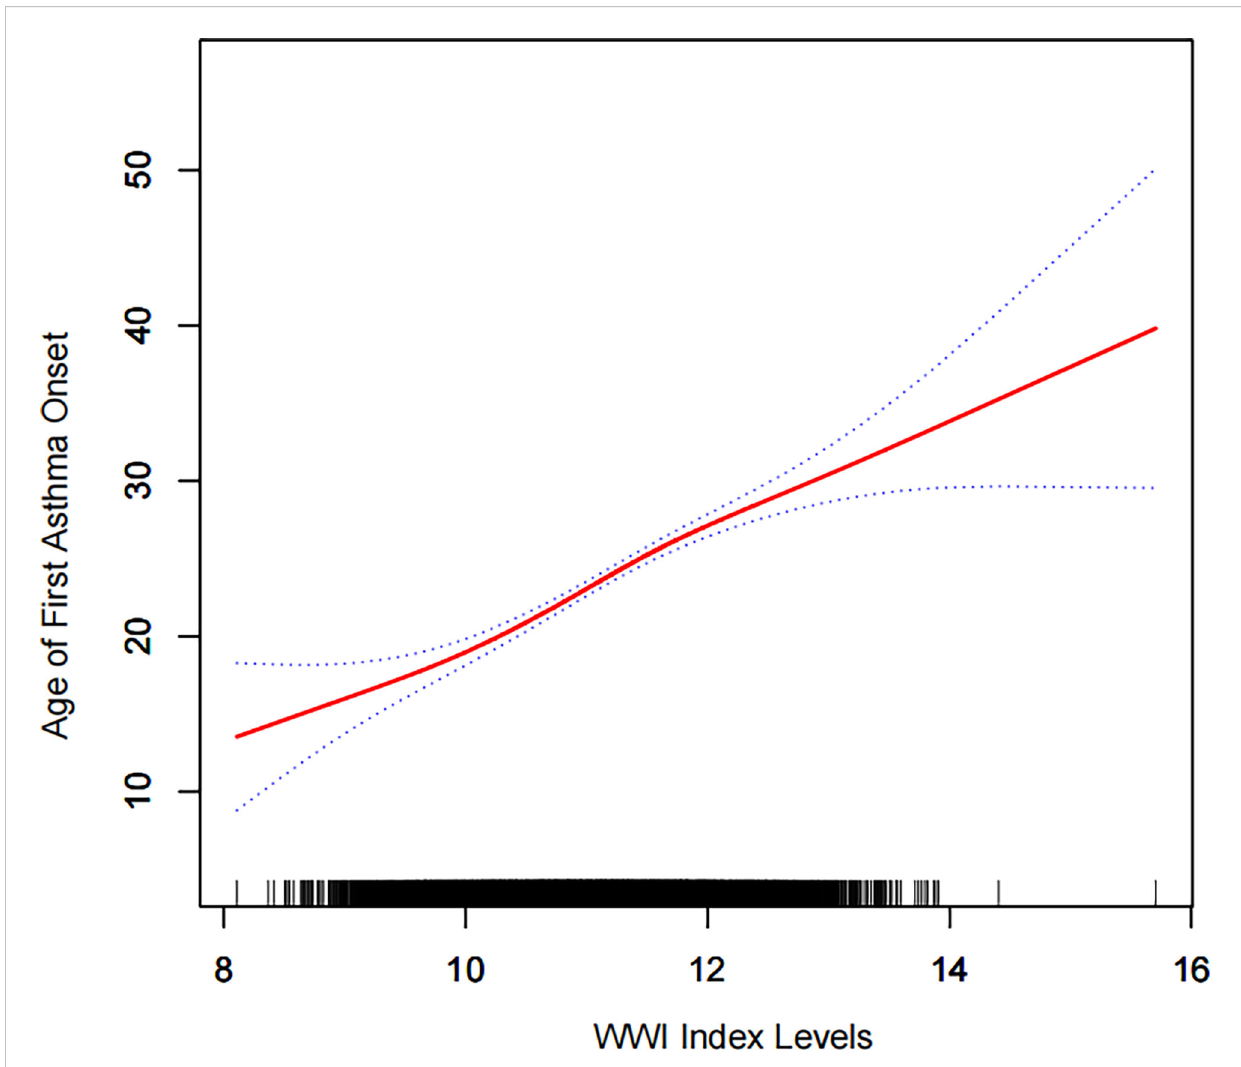
FIGURE 3 Density dose-response relationship between WWI index with onset age of prevalence.The area between the upper and lower dashed lines is represented as 95% CI. Each point shows the magnitude of the WWI index and is connected to form a continuous line.Adjusted for all covariates except effect modi fi